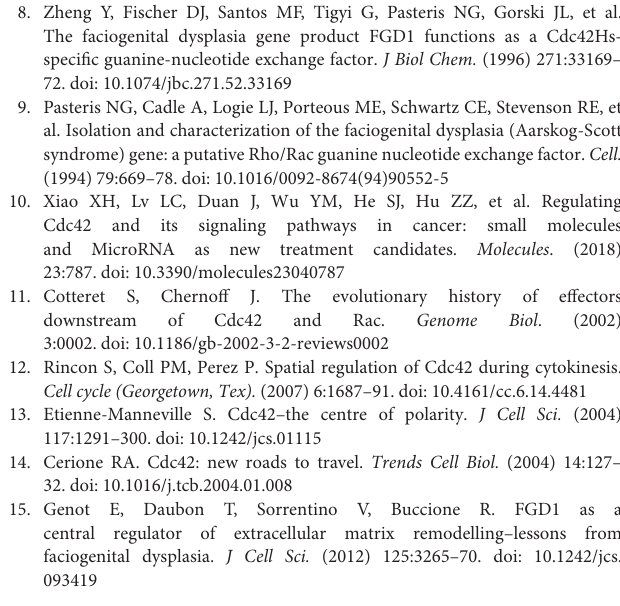
Supplementary Figure S1 | Genetic diagnosis. (A) A schematic showing the filtering procedure of variants obtained by whole-exome sequencing. The number indicates the number of variants passed for each step. (B) Pathogenic assay for FGD1 N424D variant. Supplementary Table S1 | The 11 corresponding SNPs. OMIM, Online Mendelian Inheritance in Man; ACMG, American College of Medical Genetics and